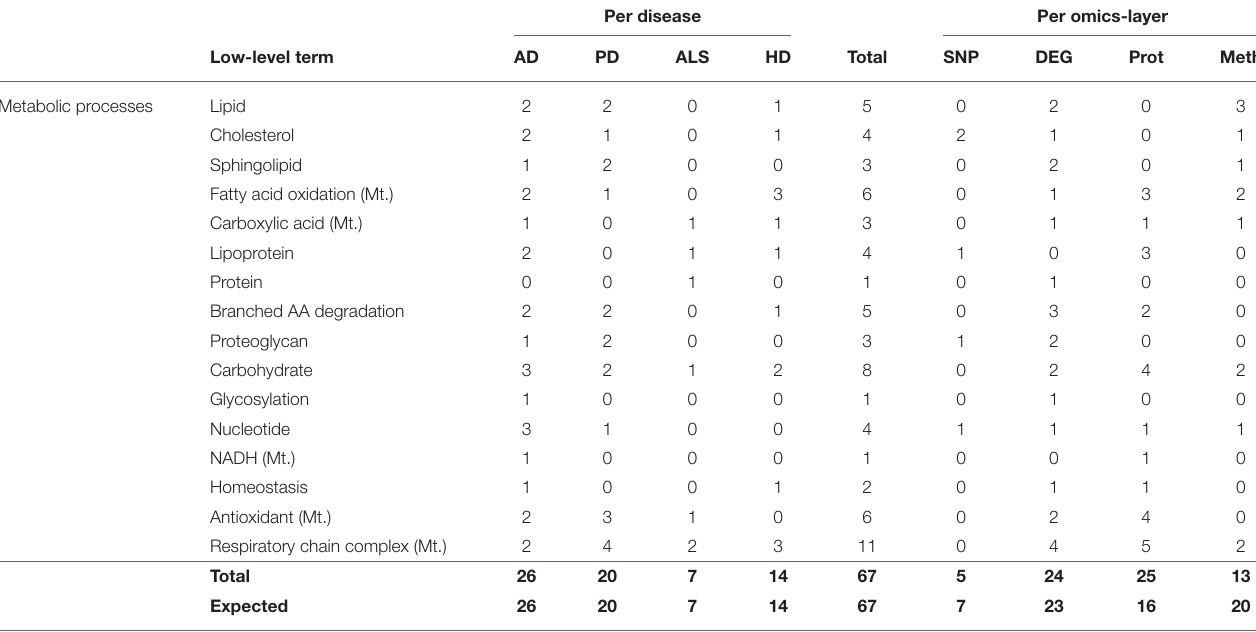
TABLE 8 | Accumulated number of low-level terms per NDD and per omics-layer for the hallmark Metabolic Processes. Per disease Per omics-layer Low-level term AD PD Metabolic processes